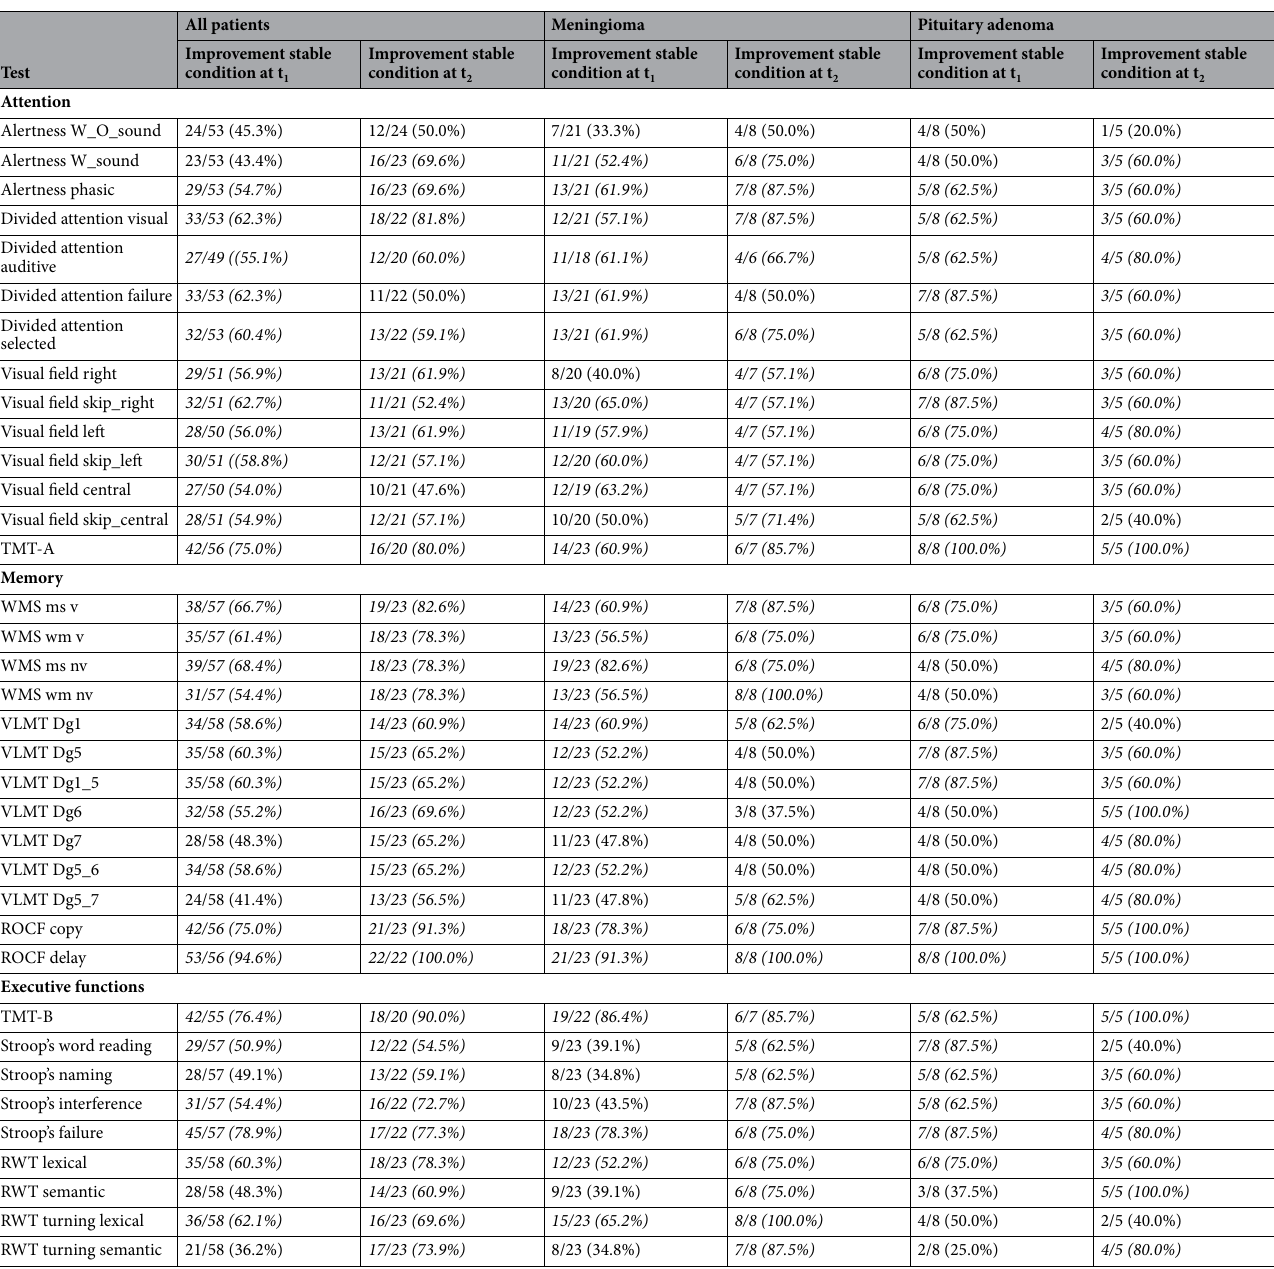
Table 2. Patients with improvement of cognition and/or stable cognition after surgery. Data are shown as numbers of patients with improvement/stable condition of cognitive functions in relation to all patients performing this subtest immediately after surgery and during follow-up. Improvement > 50% shown in